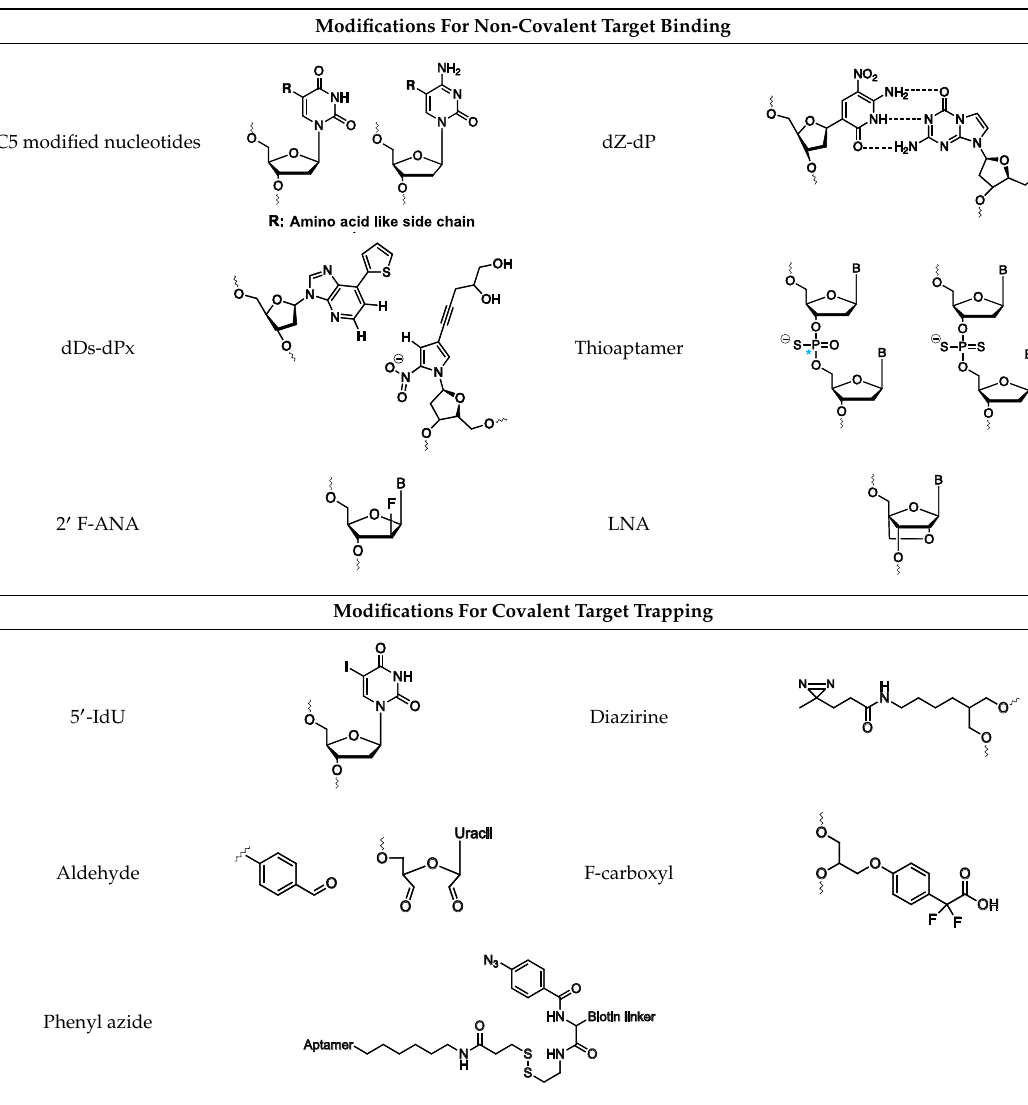
Table 1. Overview of aptamer modifications discussed in this review. dZ—6-amino-5-nitro-3-(1 (cid:48) - β -D-